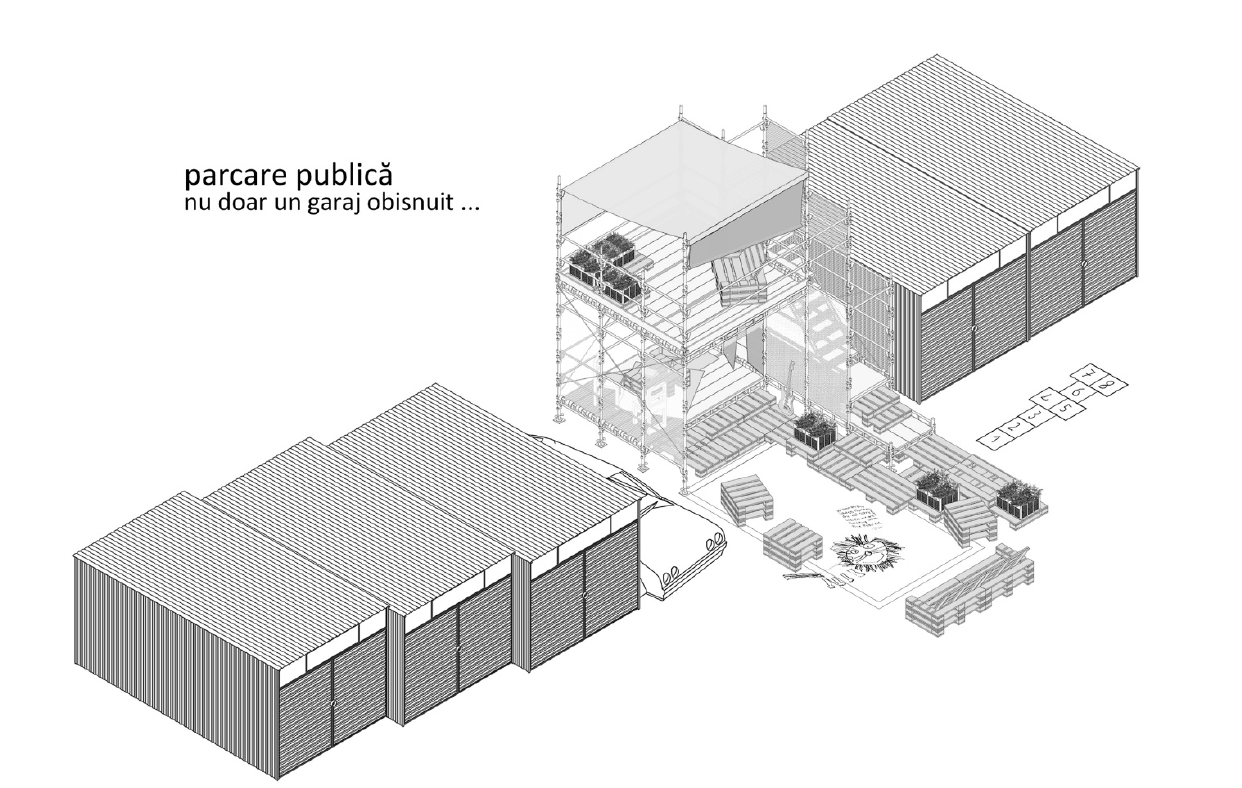
Figure 11: The 2016 workshop poster: “ Parcare publi că , nu doar un garaj obisnuit ... ” (Public Parking, not only an ordinary garage